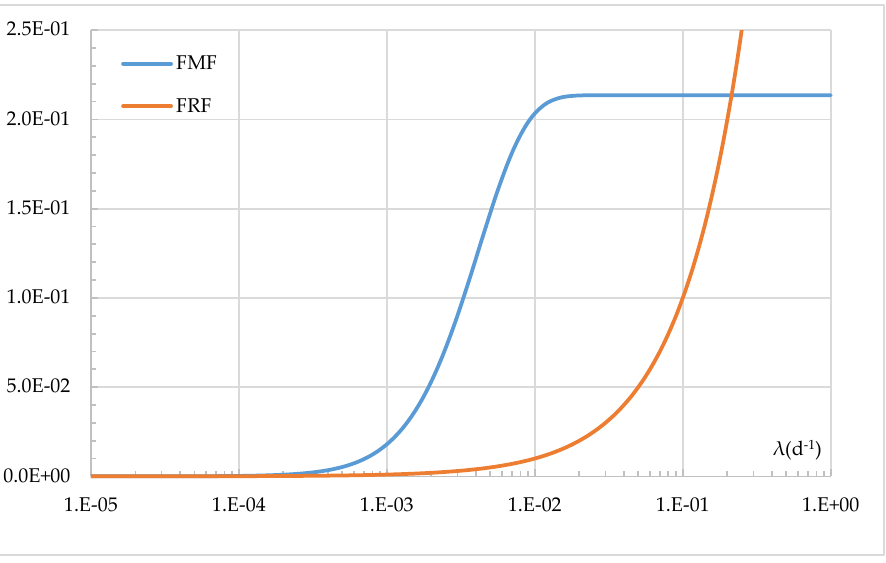
− 1 ). −1 −1 𝜆𝜆 = 2.14 × 10 𝑑𝑑